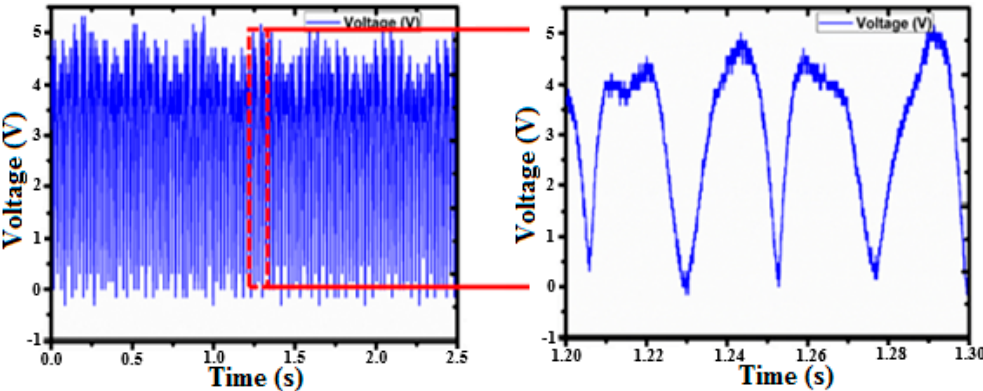
Figure 16. Combined (TENG-EMG) open circuit voltage analysis at the speed of 251 rpm.